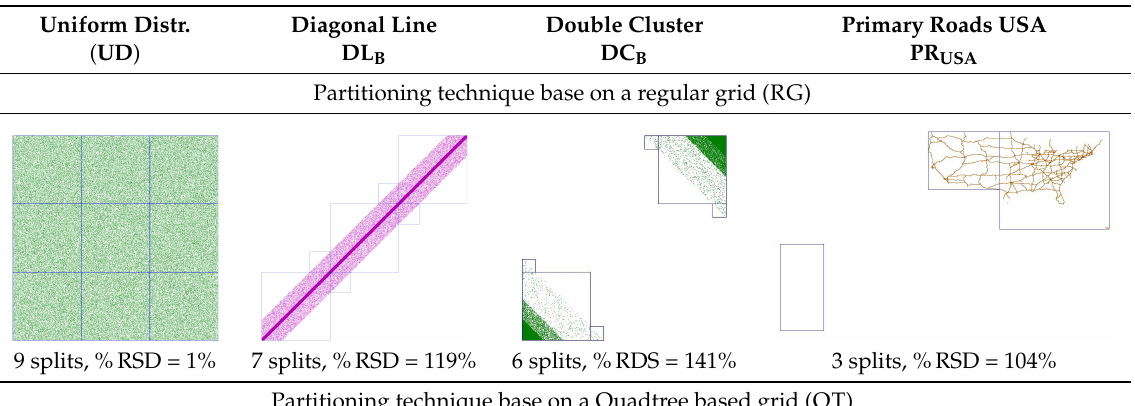
Table 2. Global index grids for synthetic and real